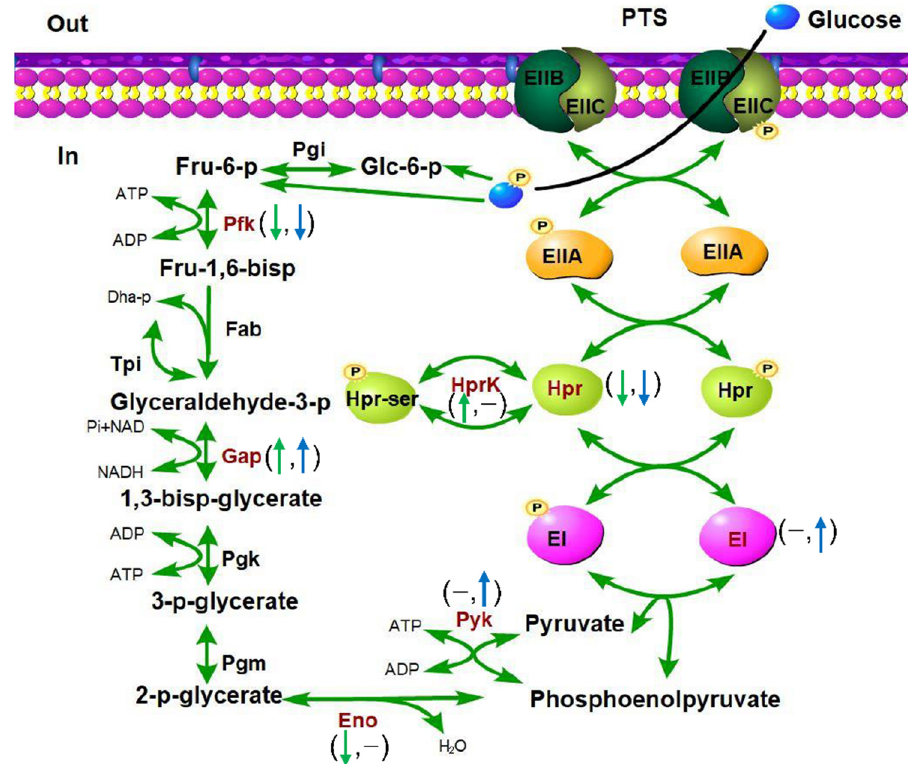
Figure 9. Proteins involved in bacterial glycolysis and carbohydrate transport with altered phosphorylation levels in Δ stp and Δ stk . The names of the proteins with altered phosphorylation levels are shown in dark red. In the brackets, the green arrow on the left indicates the change in phosphorylation level in the ∆ stp strain compared with WT ( p < 0.05), and the blue arrow on the right indicates the change in the ∆ stk strain compared with WT ( p < 0.05). The hyphen indicates no significant change ( p > 0.05). Pgi, phosphoglucose isomerase; Pfk, phosphofructokinase; Fba, fructose-1,6-bisphosphate aldolase; Tpi, triosephosphate isomerase; Gap, glyceraldehyde-3-phosphate dehydrogenase; Pgk, phosphoglycerate kinase; Pgm, phosphoglycerate mutase; Eno, enolase; Pyk, pyruvate kinase; EI, PTS-enzyme I; Hpr, phosphocarrier protein; HprK, HPr kinase/phosphorylase. Table 2. Proteins with down- and up-regulated abundance after phospho-peptide enrichment in Δ stk and Δ stp compared with WT.